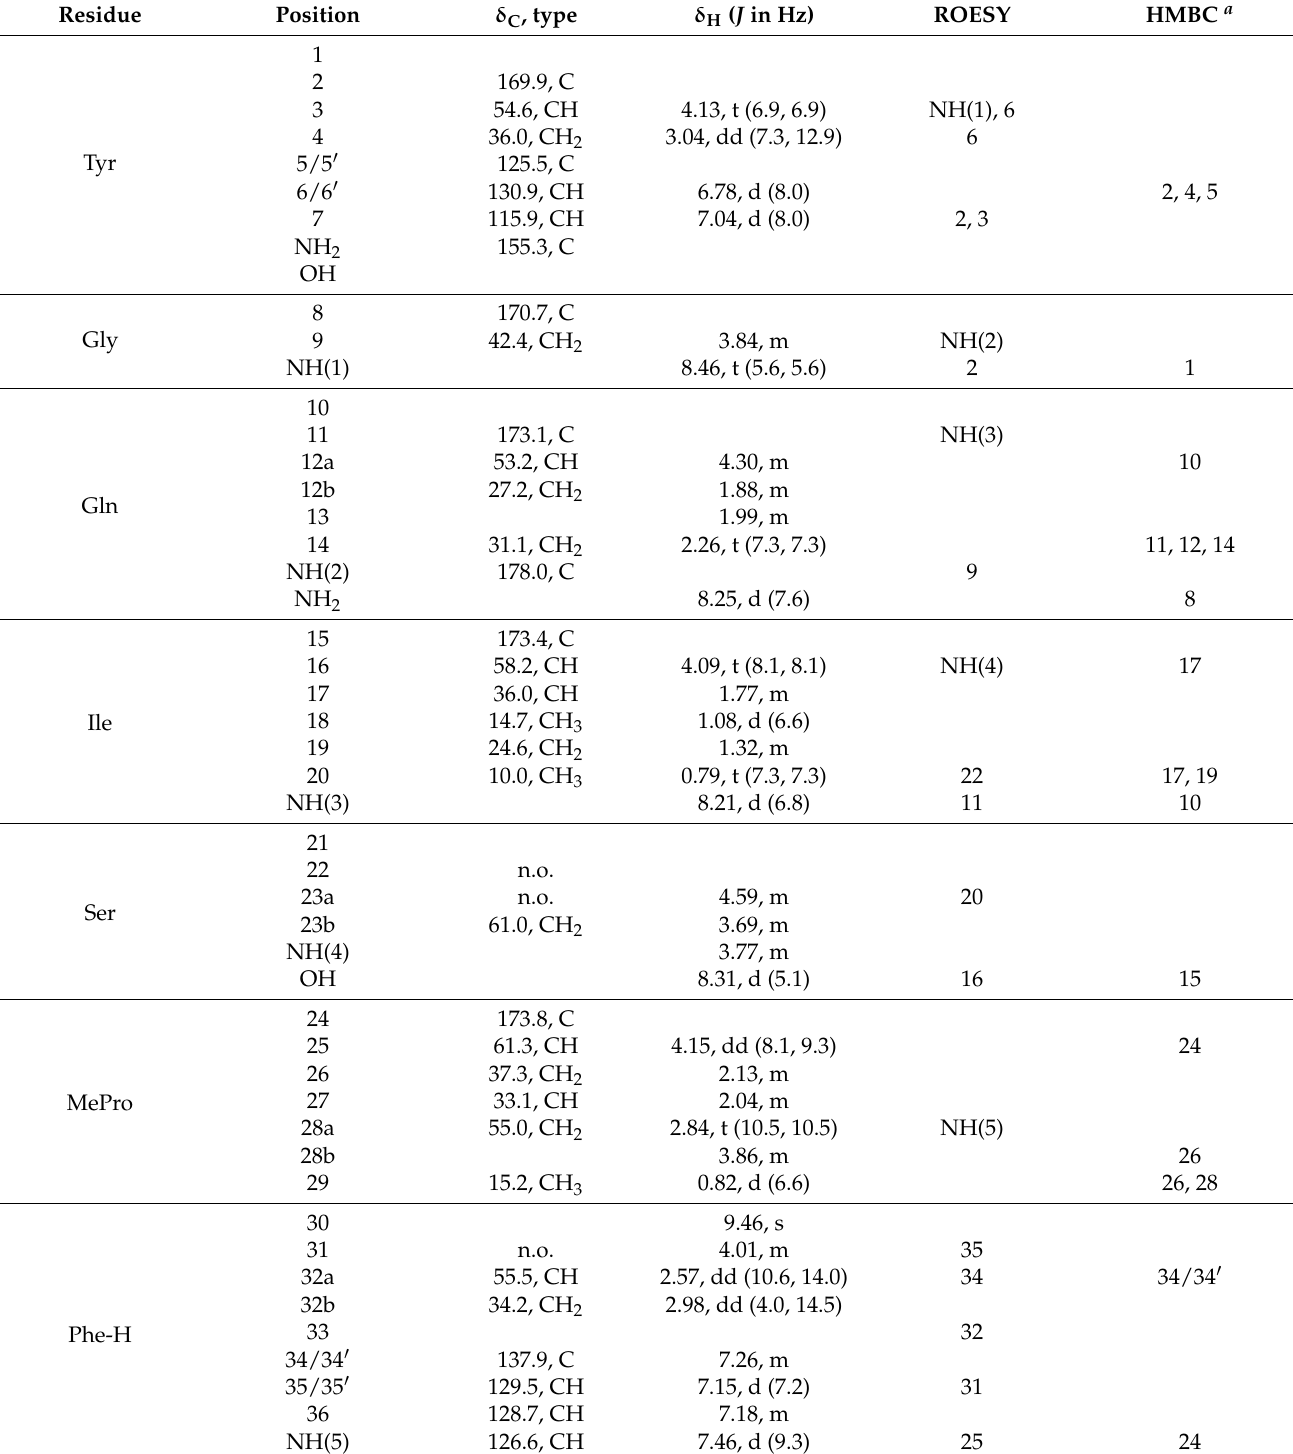
Table 2. Nuclear Magnetic Resonance (NMR) Spectroscopic Data for Ncp-A2-L (Tyr-Gly-Gln-Ile-Ser-MePro-Phe-H).